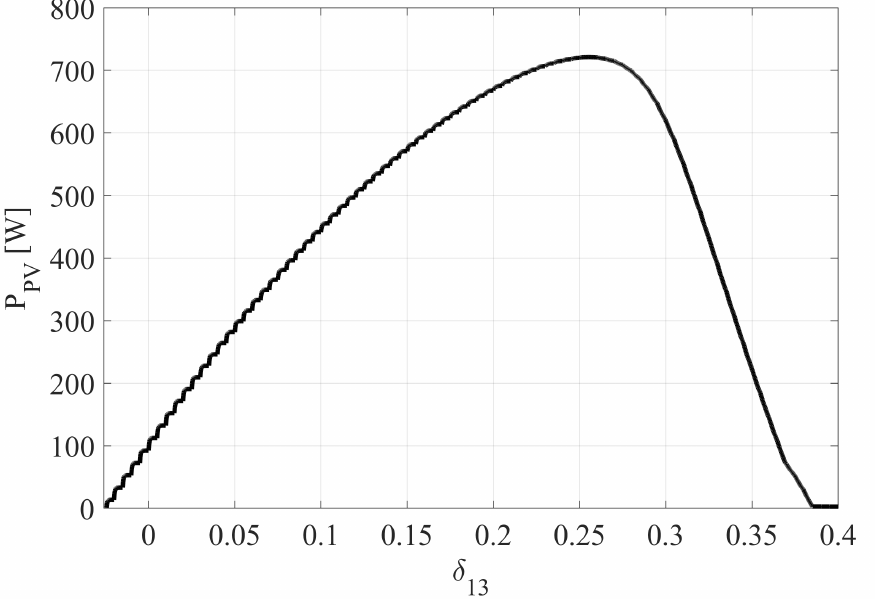
Figure 9. Simulation results of the PV module power transfer in relation to the phase shift between the PV port and the battery